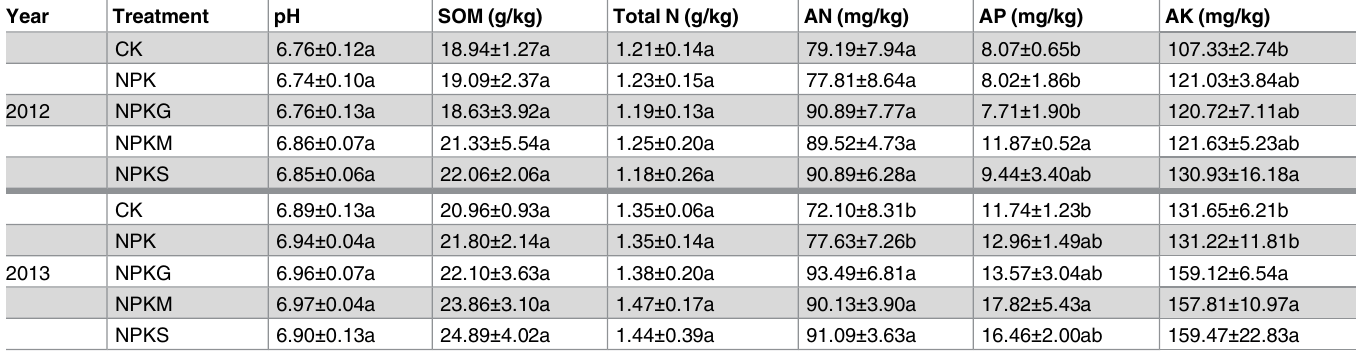
Data are means ± SE, n = 3. Different letters indicate significant differences between fertilizations at P < 0.05. Abbreviations: AK, available potassium; AN, availablenitrogen; AP, available phosphorus; SOM, soil organic matter; TN, total